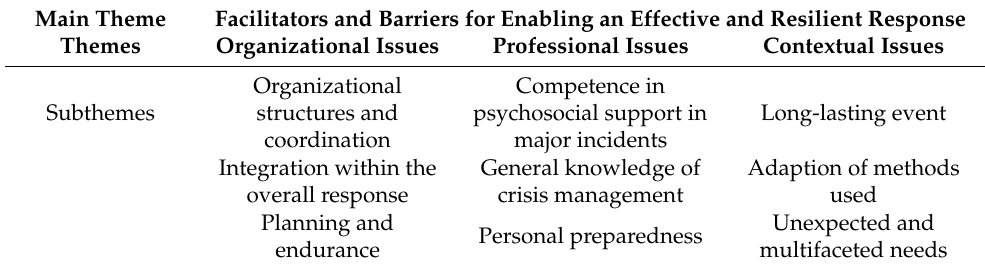
Table 2. Overview of